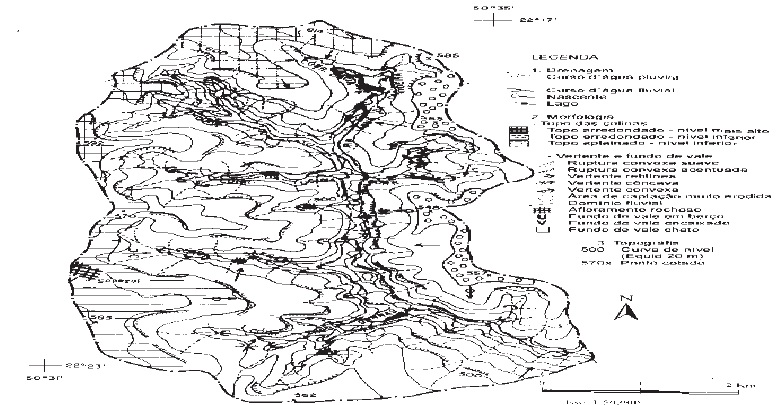
Figura 1. Localização da microbacia do ribeirão Água da Cachoeira, Planalto Ocidental